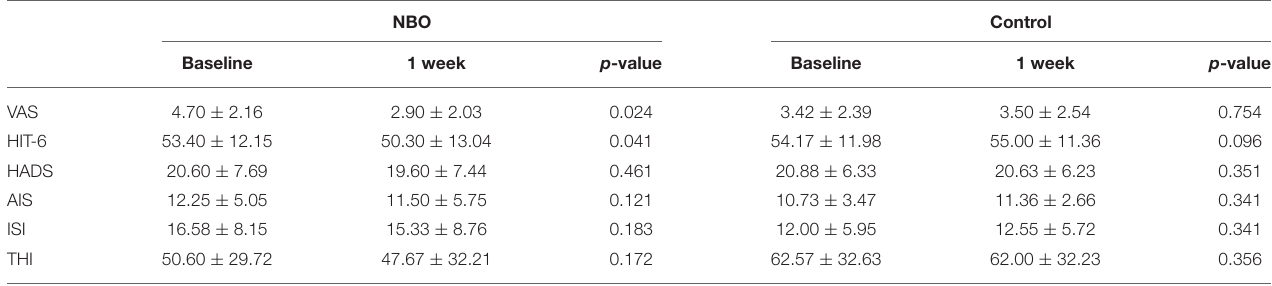
TABLE 3 | The average scores of the patients in the two groups at baseline and 1-week follow up. NBO Control Baseline 1 week p -value Baseline 1 week p -value 4.70 ± 2.16 2.90 ±